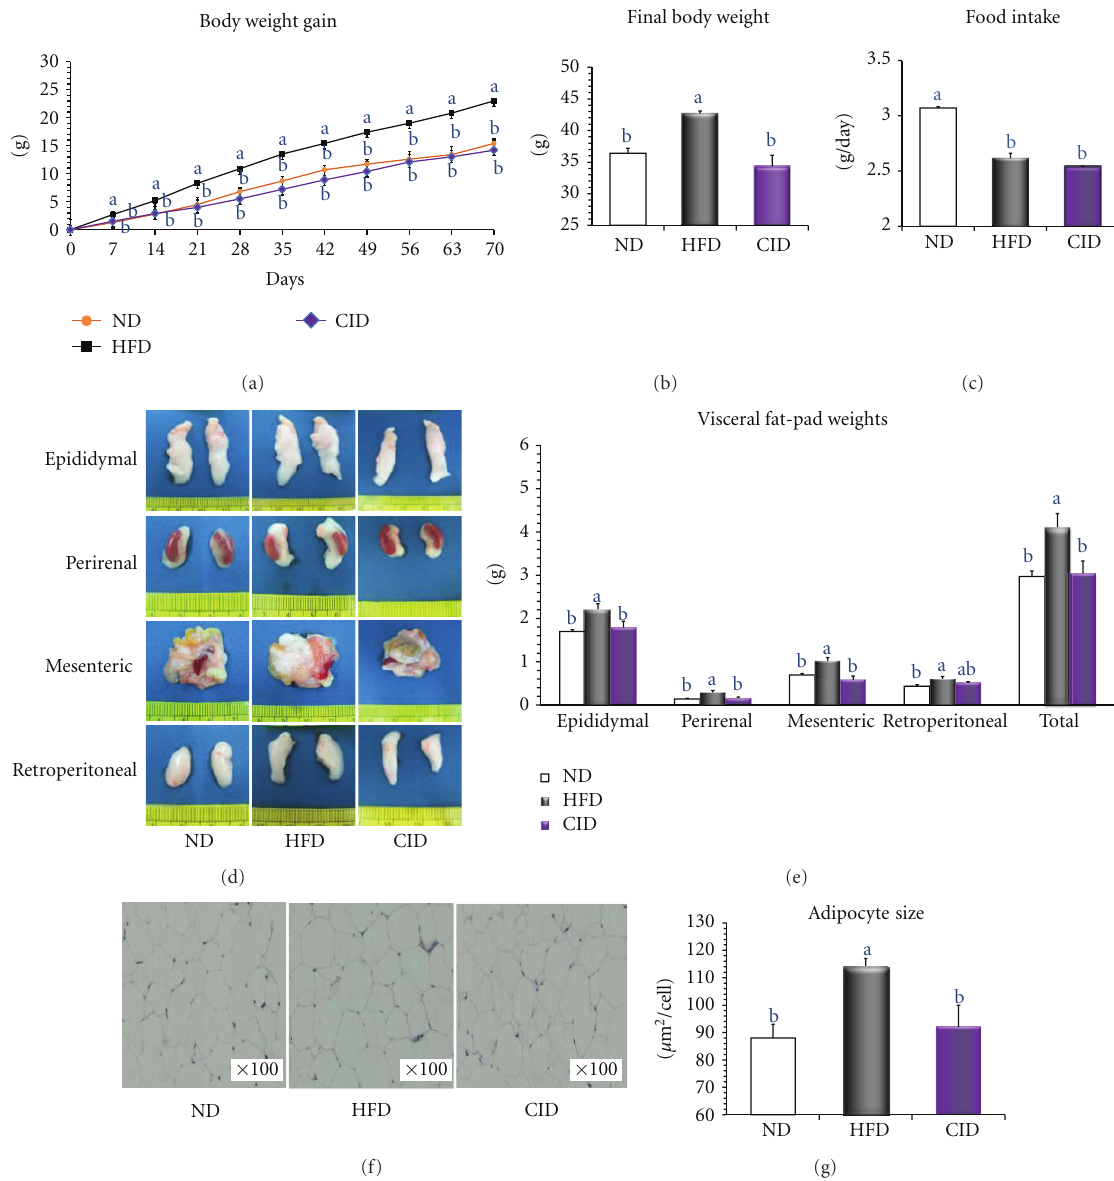
Figure 1: E ff ect of dietary cinchonine on body weight and fat-pad weights. Mice were fed on ND, HFD, or CID. (a) Changes in body weight gain and (b) final body weight after 10 weeks. (c) Food intake and (d), (e) fat-pad weights. (f) Representative photographs of adipocytes in the epididymal tissue of mice, 100x magnification. (g) Quantitative measurements of adipocyte size (the average cross-sectional area of each adipocyte, um 2 /cell) in mice fed the ND, HFD, or